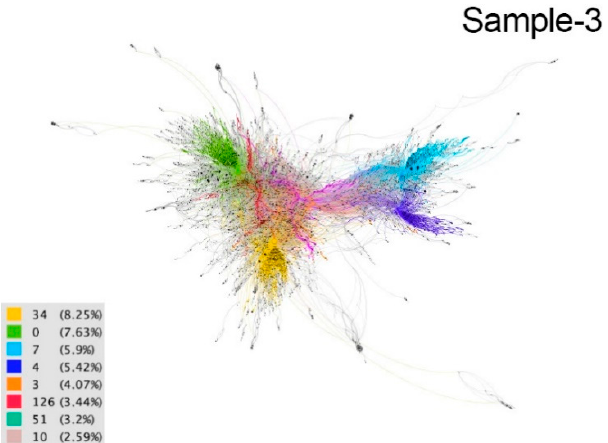
Figure 4. Graph of sample 3. Community detection based on modularity [66] and according to intermediation centrality [63] of sample 1. Source: Gephi [67].